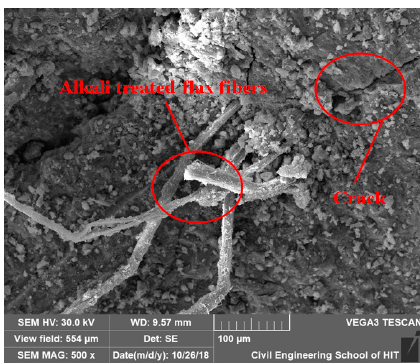
Figure 7. SEM image of F1 showing microfractures at 500 × .